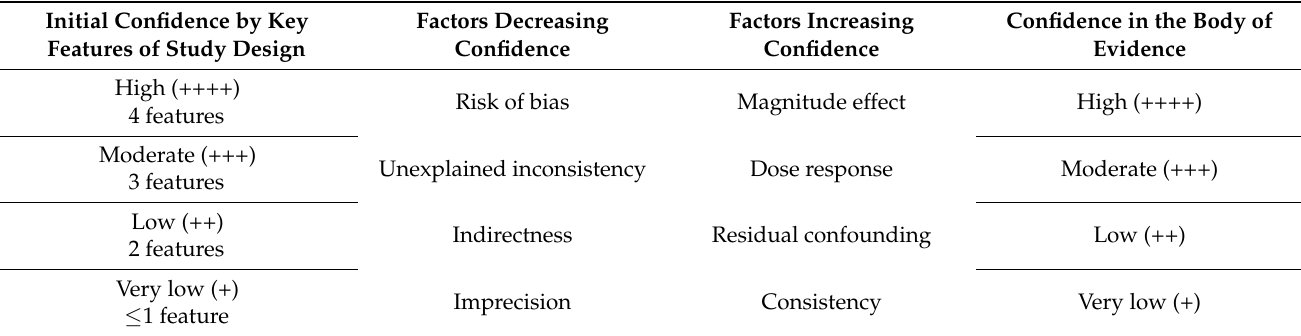
Table 2. Accessing confidence in body of